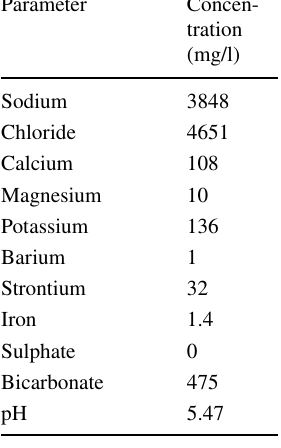
Table 1 Core selection used for core floods